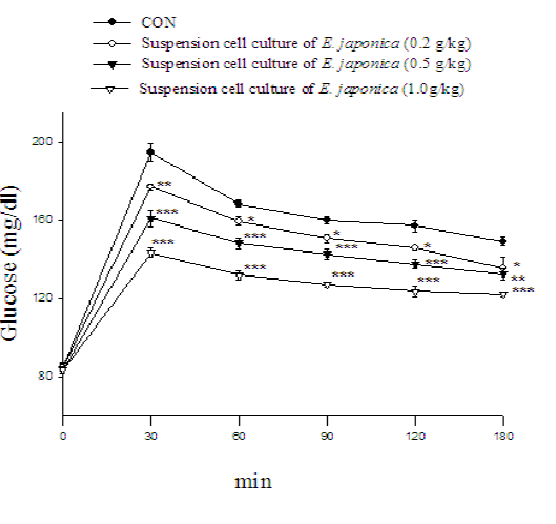
Figure 6. Effects of cell suspension culture of Eriobotrya japonica on oral glucose tolerance in normal mice. Animals in all groups received oral glucose 30 min after the extract administration. Blood samples were collected and centrifuged at 3,000 rpm for 10 min. Each point is the mean ± S.E. of 5 separate mice. * p < 0.05, ** p < 0.01, *** p <